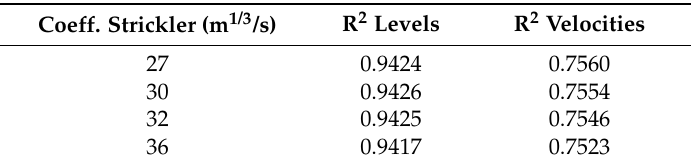
Table 1. Strickler coefficients for the seabed roughness and coefficients of determination between the model results and field data.